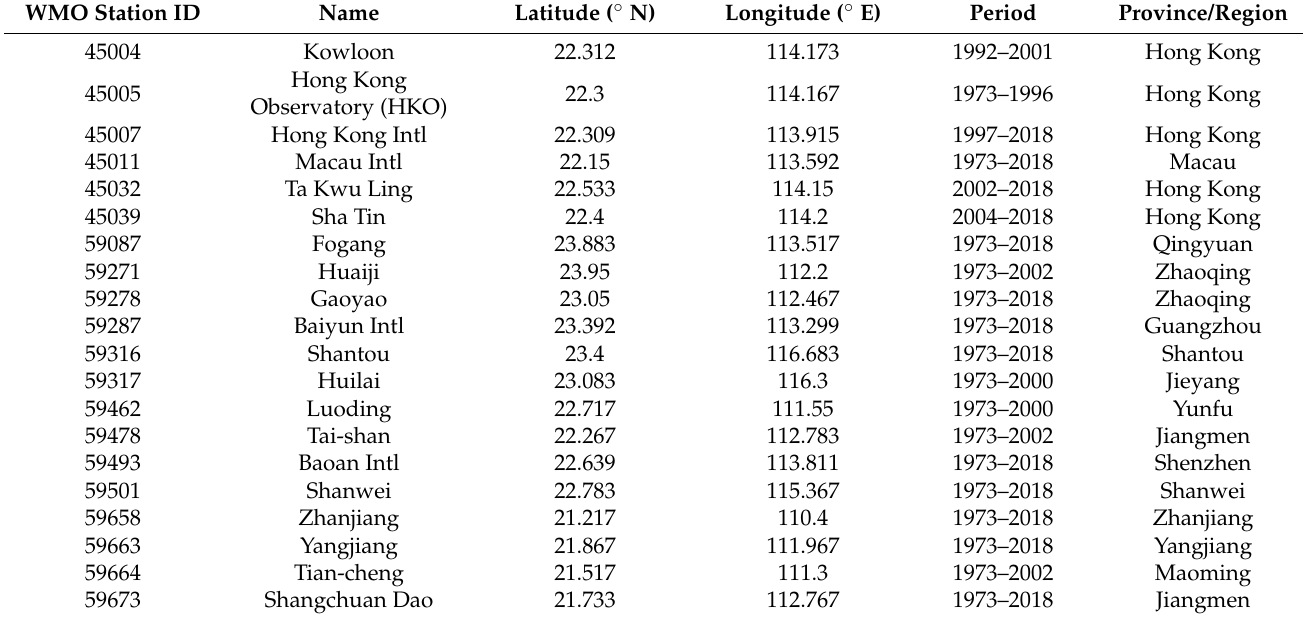
Table 1. Information of selected stations in Guangdong, Hong Kong, and